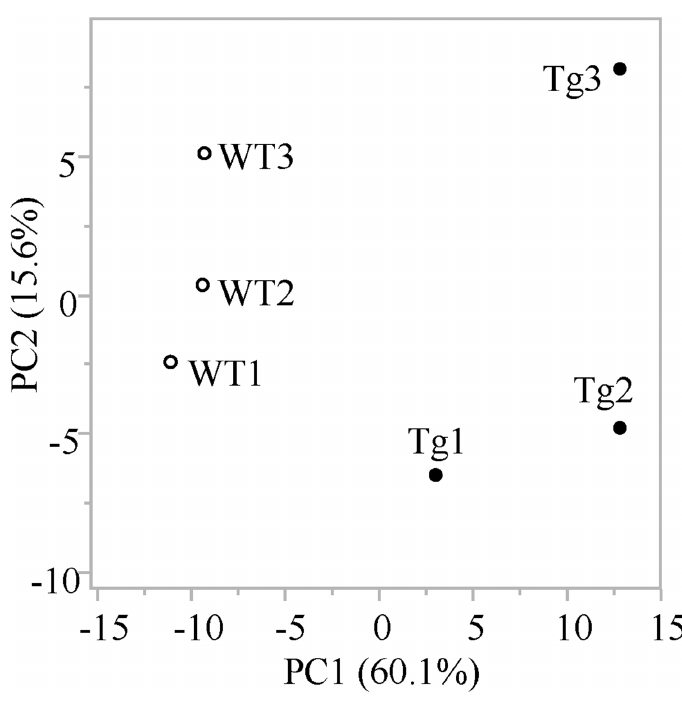
Fig 1. Principal component analysis (PCA) of the metabolomic datasets of the skeletal muscle of PGC-1 α -Tg mice and WT mice. Three mice were used in each group (WT1, WT2, and WT3 for wild-type and Tg1, Tg2, and Tg3 for PGC-1 α -Tg mice). PCA was conducted with the determined data peaks by using SampleStat ver. 3.14. Plots of WT (open circles) and PGC-1 α -Tg mice (filled circles) are clearly distinguished on the PC1 axis